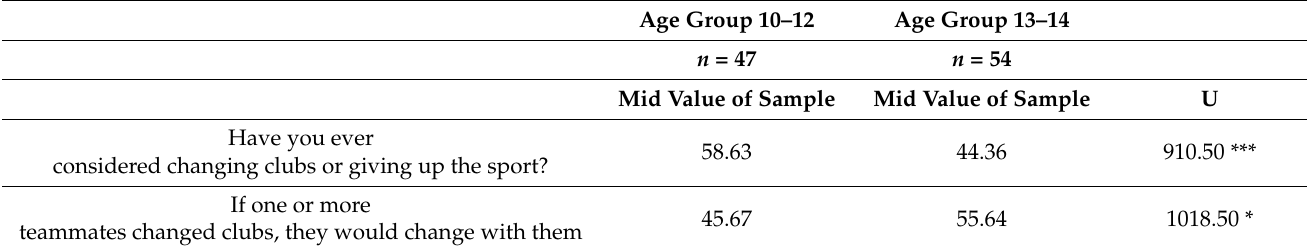
Table 3. Differences and associations at the age group level: